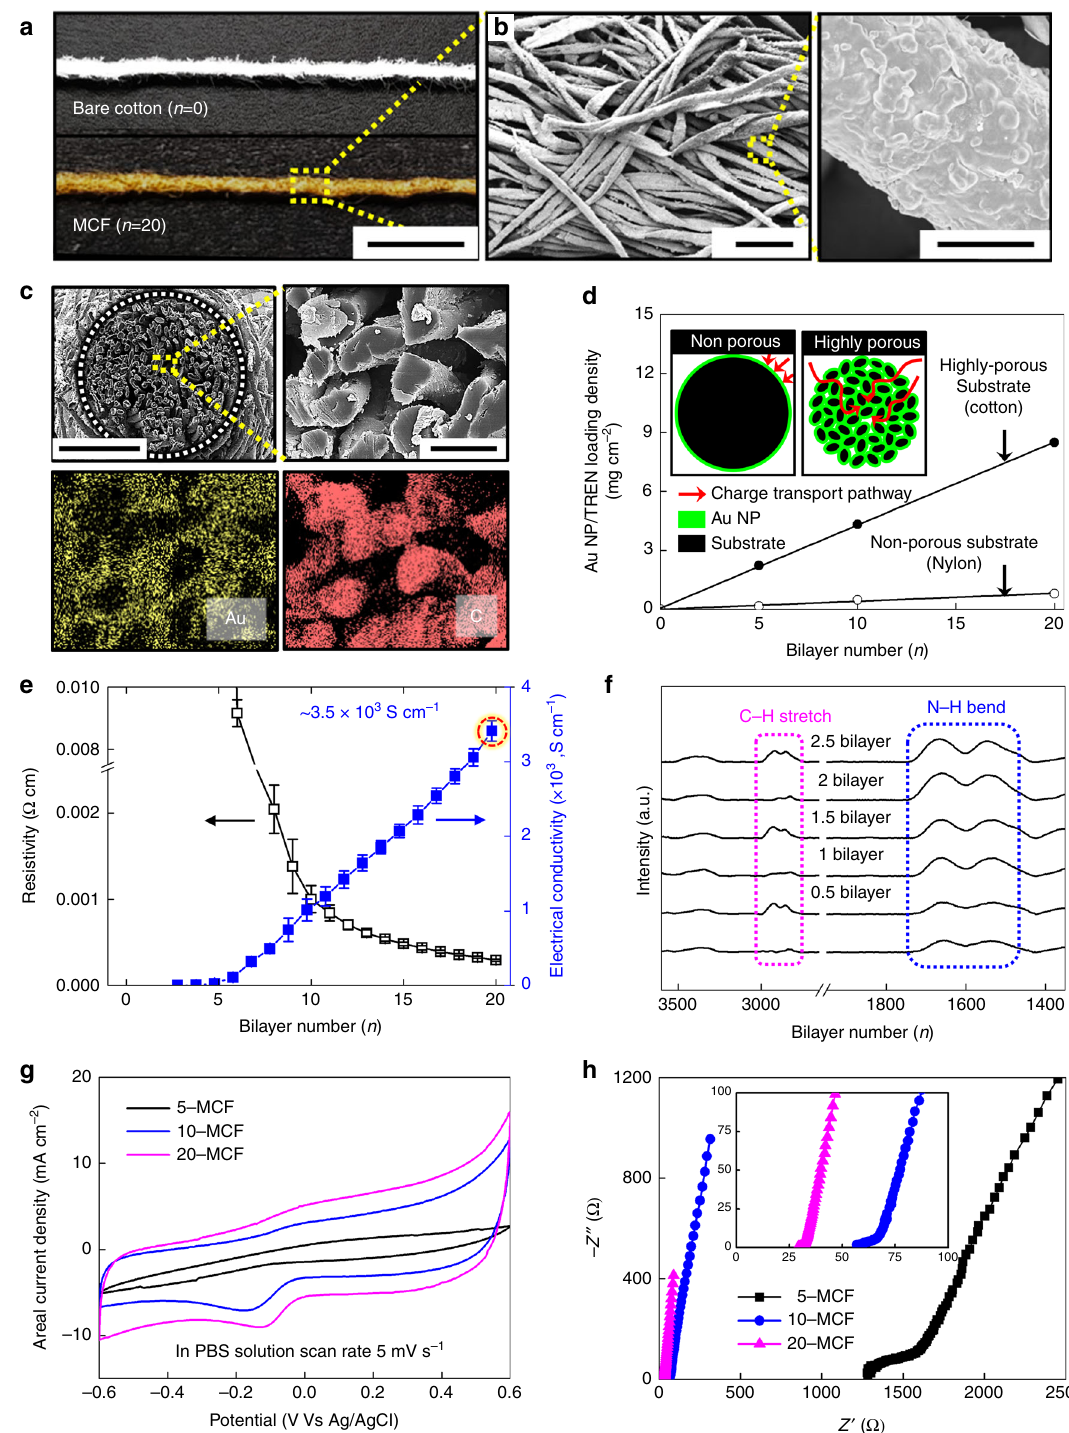
Fig. 2 Characterization of the metallic cotton fi ber electrode. a Photographic images of bare cotton fi ber (i.e. 0-MCF, metallic cotton fi bers is abbreviated as MCF) and 20-bilayered metallic cotton fi bers (20-MCF) (scale bar, 1 mm). b Field-emission scanning electron microscopy (FE-SEM) images of the 20- MCF (scale bar, 50 µ m (left) and 5 µ m (right)). c Cross-sectional FE-SEM, and energy-dispersive X-ray spectroscopy (EDS) mapping images of the 20- MCF electrode with a diameter of ~200 μ m (scale bar, 100 µ m (left) and 20 µ m (right)). d Change in the areal loading amount of the (tetraoctylammonium bromide-stabilized Au nanoparticle (TOA-Au NP)/tris-(2-aminoethyl)amine (TREN)) n multilayers adsorbed onto porous cotton fi bers and nonporous nylon fi bers with the same diameter (~200 μ m) as the number of bilayers ( n ) increases. e Resistivity and electrical conductivity of n -MCFs as a function of n . The error bars show the standard deviation from the mean value of electrical conductivities for 3 − 5 independent experiments. f Fourier transform infrared (FTIR) spectra of the (TOA-Au NP/TREN) n multilayers as a function of n . g CV curves of n -bilayered metallic cotton fi bers ( n -MCF) at a scan rate of 5 mV s − 1 in a phosphate-buffered saline (PBS) solution. h Nyquist plots of n -MCFs in the frequency range 0.2 Hz to 100 kHz. Inset: Nyquist plots magni fi ed in the high-frequency range. The equivalent series resistance (ESR) values of n = 5, 10, and 20 were 1346, 60, and 30 Ω ,